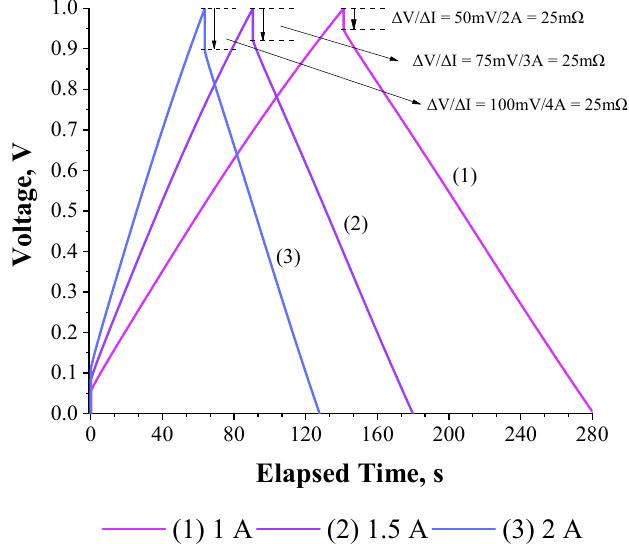
Figure 4. Experimental GCD curves obtained for a 200F commercial supercapacitor (2.7V D35H62 PTH S0016) as a function of the applied current.